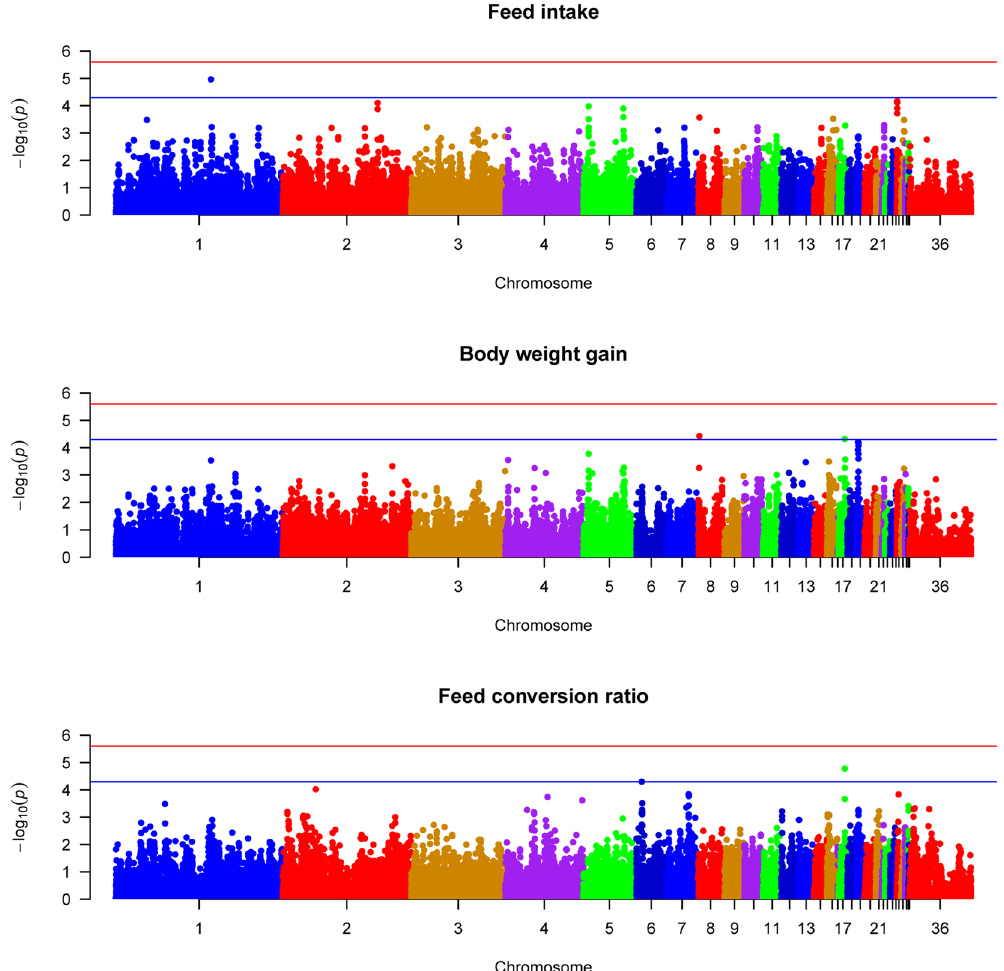
Figure 3. Manhattan plots of genome wide association results for feed efficiency traits using mixed linear model analysis. Chromosomes 29, 30 and 36 represent linkage groups LGE22C19W28_E50C23, LGE64, and chromosome Z, respectively. Red and blue lines indicate genome wide and suggestive significance thresholds,